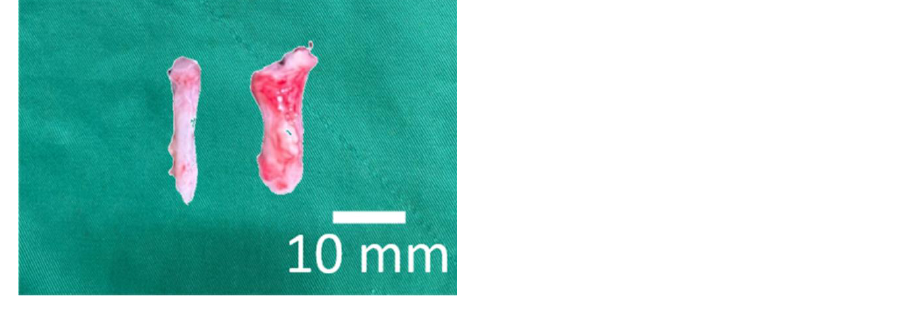
Figure 10. Photo of retrieved tendons (left: normal, right: repaired by the DCB – PLGA nanofibers).